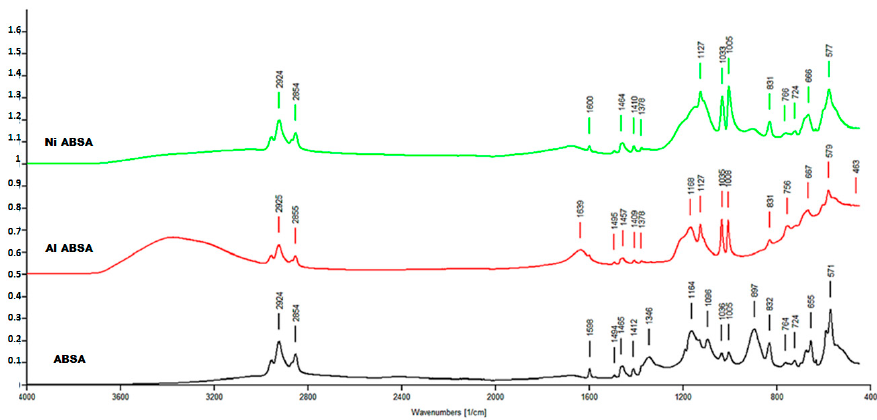
Figure 3. FTIR spectra of the ABSA (black) and metal ABSA (green—NiABSA, red—AlABSA).